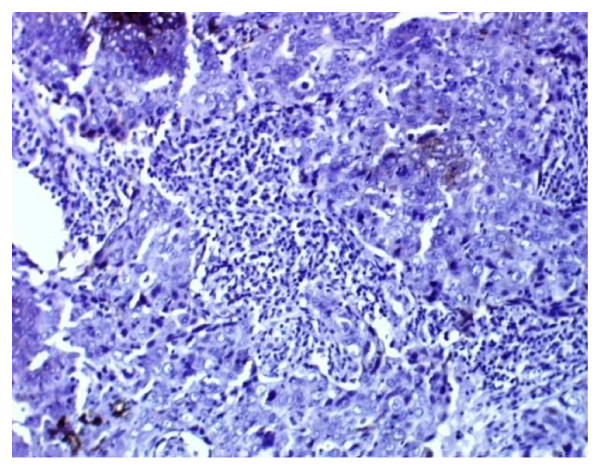
Example of immunohistochemistry for GLUT-1. Example of biopsy stained for GLUT-1 (×40). This tumor showed a small positive percentage.